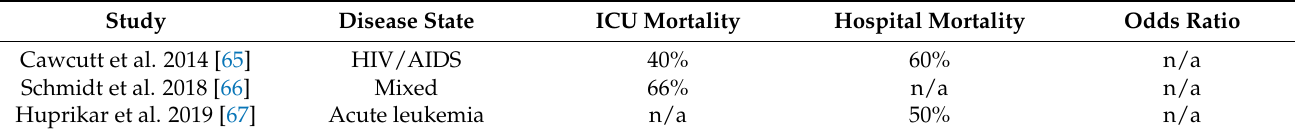
Table 4. Evidence for the use of vvECMO in immunocompromised patients and the respective